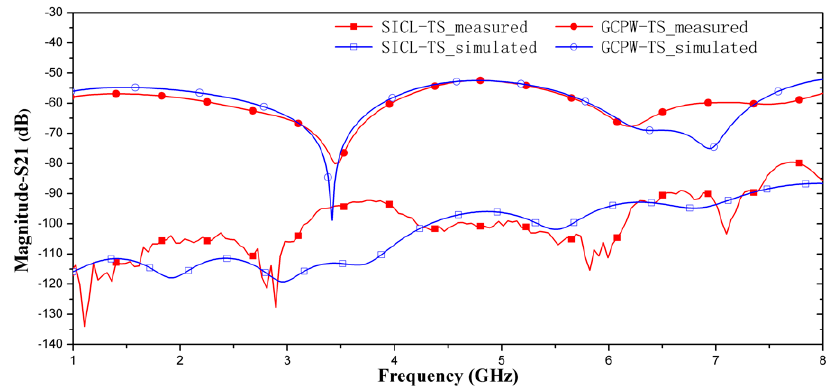
Figure 6. Comparison between simulated and measured | S 21 | of the SICL-TS and the GCPW-TS.